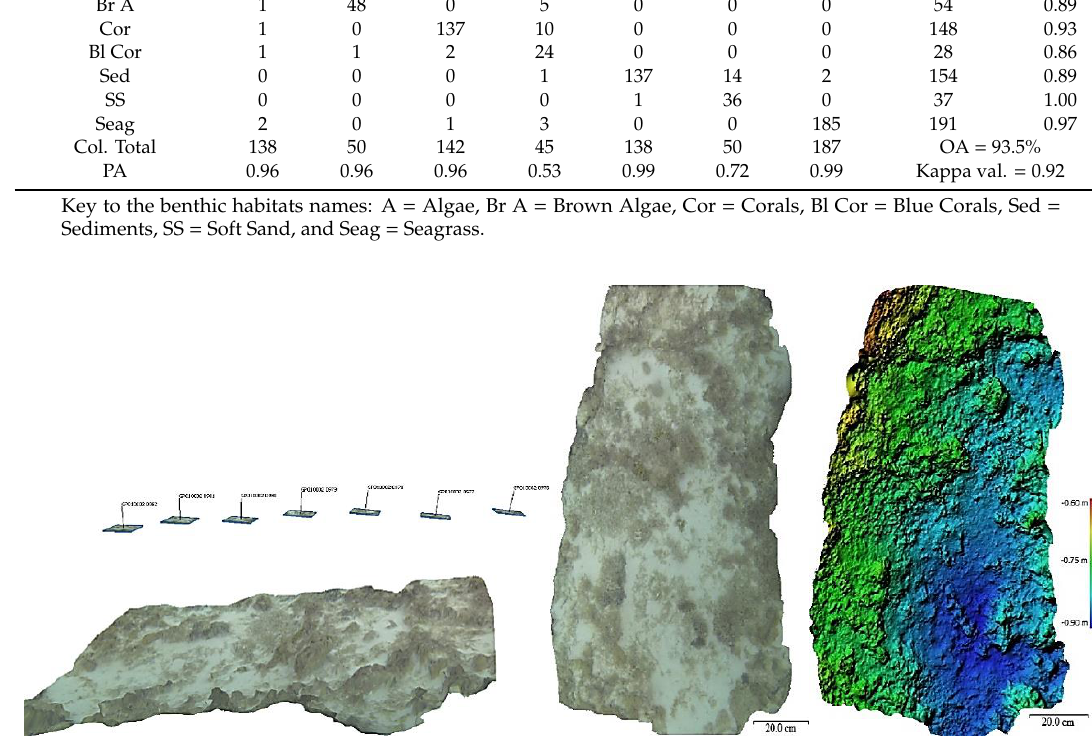
Figure 7. 3D perspective view, orthophoto mosaic, and digital terrain model (DTM) for a categorized algae sample.